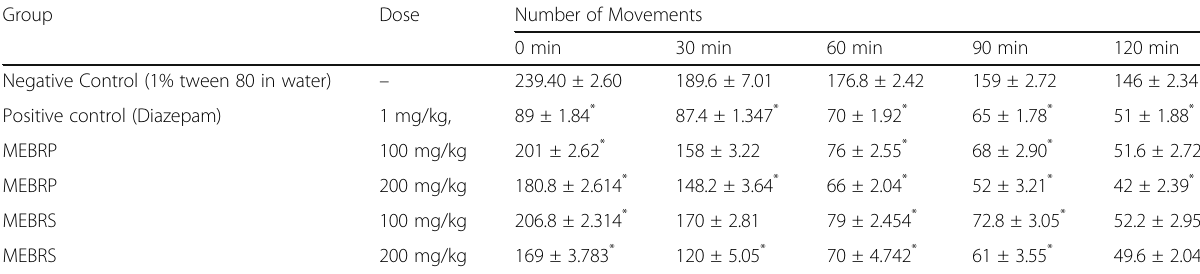
Table 4 Depressant effects of the methanol extract of the Baccaurea ramiflora pulp and seed on open field test in mice Group Dose Number of Movements